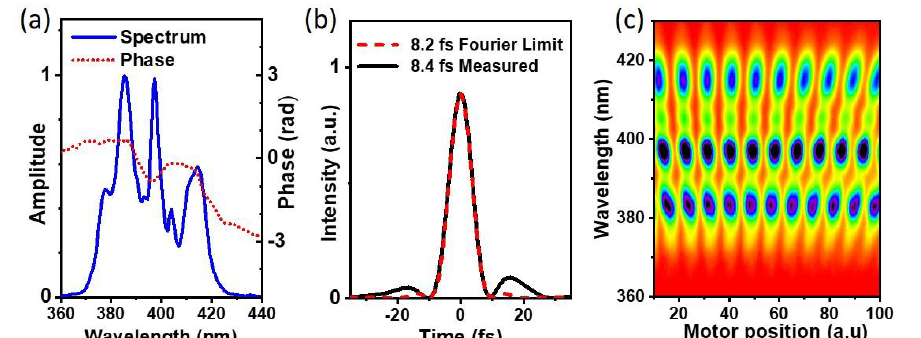
Fig. 2. a) Spectral amplitude and phase of the near-UV-blue pulse b) Temporal profile of the pulse after reconstruction of the electric field using the measured spectral amplitude and phase c) Spectrally-resolved autocorrelation of the near-UV-Vis pulses recorded by varying the time delay between both replicas with the TWINS